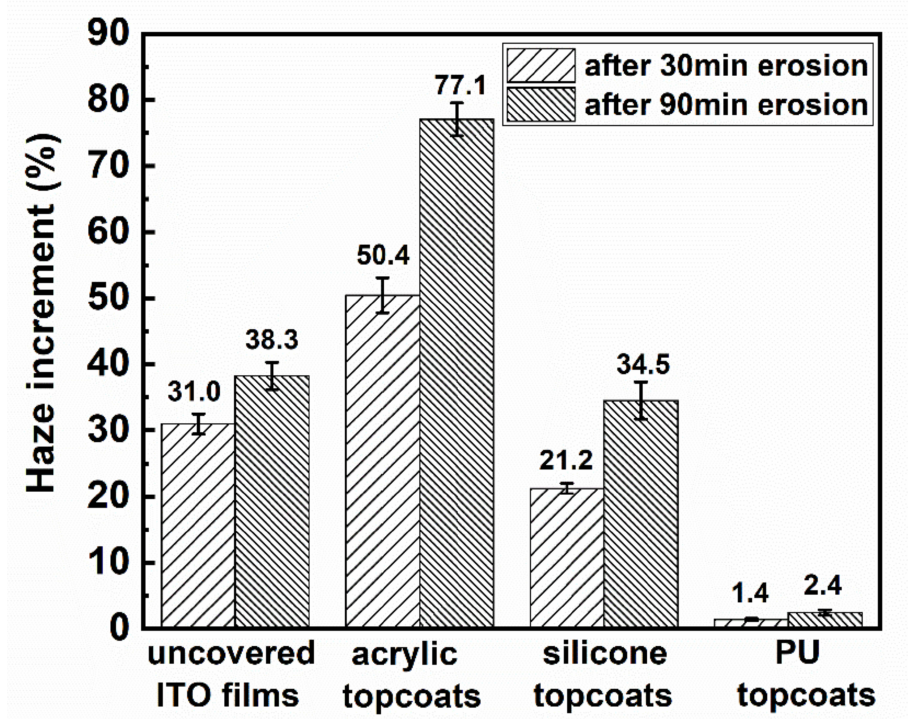
Figure 7. Variation in haze of uncovered ITO films, ITO films covered by acrylic-based, silicone and PU topcoats after sand erosion for 30 min and 90